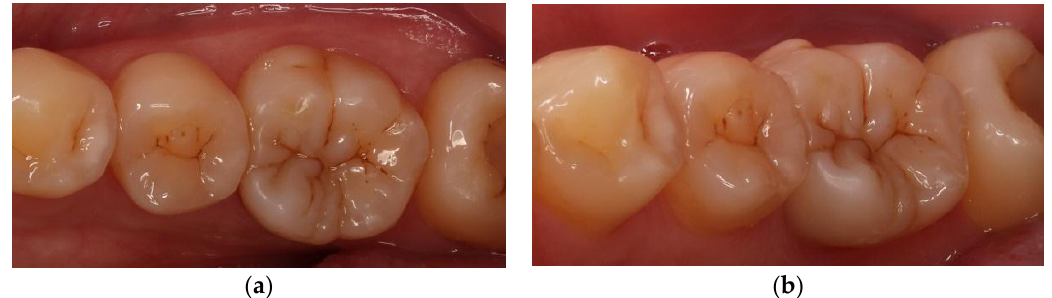
Figure 9. Follow-up after 12 months: ( a ) occlusal view; and ( b ) no obvious gap or marginal discoloration.